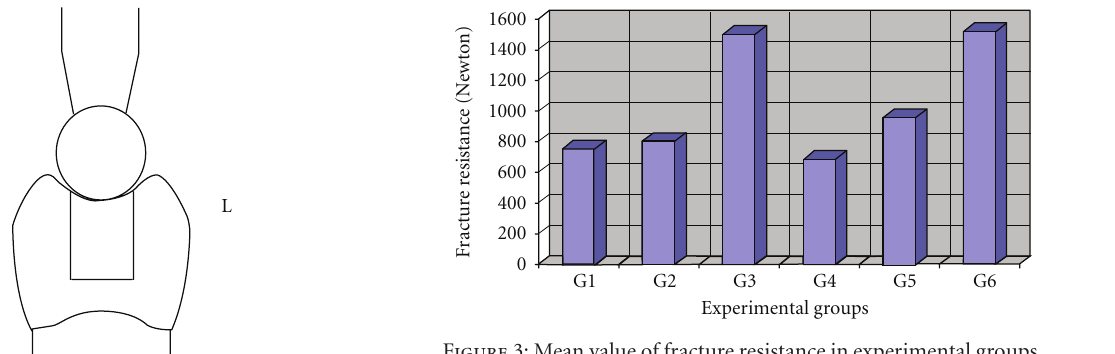
Figure 3: Mean value of fracture resistance in experimental